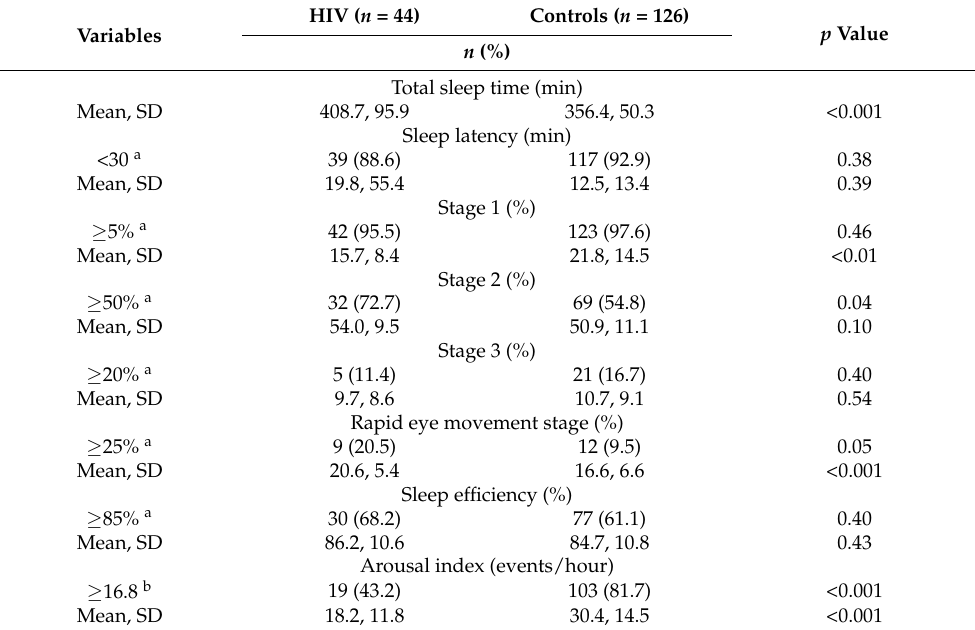
Table 2. Differences in sleep architecture by PST-derived measures between HIV-infected persons and controls.